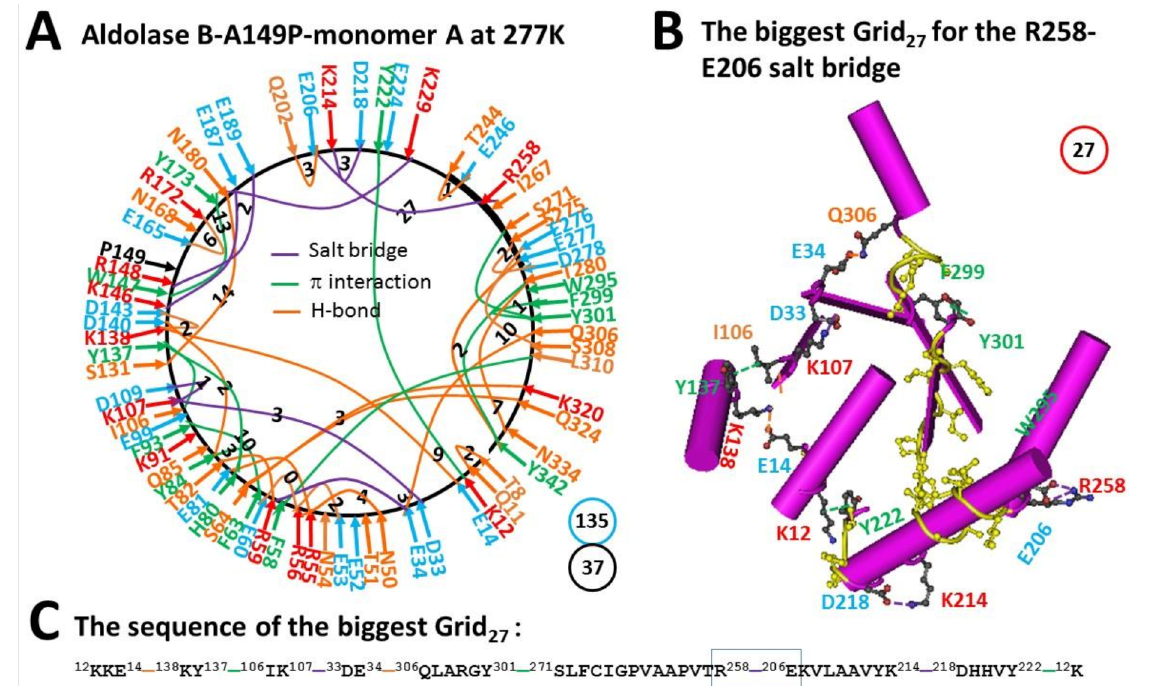
Figure 3. The grid-like non-covalently interacting mesh network along the single polypeptide chain of ligand-free monomer A in the aldolase B-A149P tetramer at 277 K. ( A ) The topological grids in the systemic fluidic grid-like mesh network. The X-ray crystallographic structure of monomer B in aldolase B-A149P at 277 K (PDB ID, 1XDL) was used for the model [2]. Salt bridges, π interactions, and H-bonds between pairing amino acid side chains along the single polypeptide chain from T8 to Y342 are marked in purple, green, and orange, respectively. The grid sizes required to control the relevant non-covalent interactions were calculated with graph theory and labeled in black. The total grid sizes and grid size-controlled non-covalent interactions along the single polypeptide chain are shown in the blue and black circles, respectively. ( B ) The structure of the biggest Grid 27 . The grid size is shown in a red circle. ( C ) The sequence of the biggest Grid 27 to control the E206-R258 salt bridge in a blue